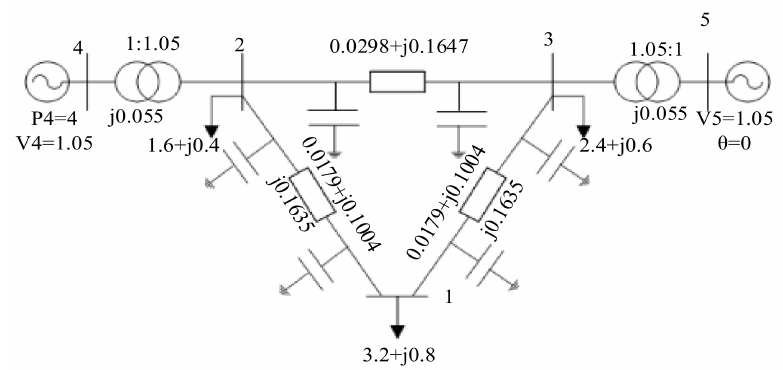
Figure 5. Network structure diagram. P and V: the power and voltage. θ : the phase angle. 1–5: the bus number. j: the imaginary